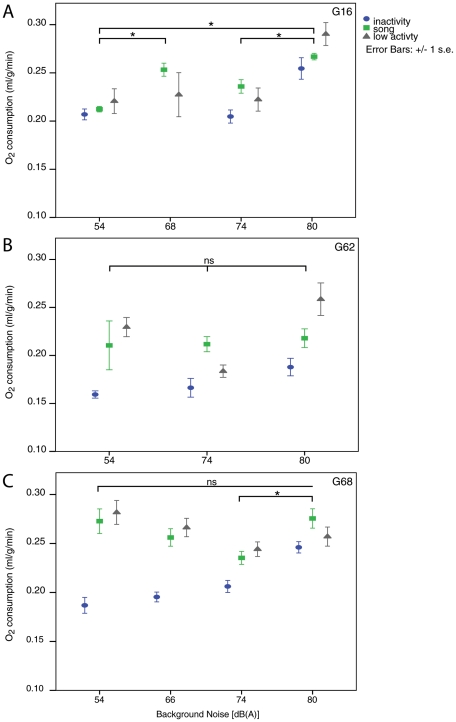
Rates of oxygen consumption during three categories of behaviour: song (green squares), low-level activity (grey triangles) and inactivity (blue circles) at different background noise conditions for three individuals.A) Rates of oxygen consumption were significantly higher during the quietest and loudest songs in only one bird, G16. However, the increase in oxygen consumption during periods of inactivity and low-level activity at the same background noise conditions were just as great, suggesting that the increase may not be due simply to the increase in song amplitude. B and C) Rates of oxygen consumption at low, intermediate and high background noise levels and song amplitudes were not significantly different in birds G62 or G68. All three birds showed an increase in oxygen consumption during periods of inactivity as background noise increased. Asterisks denote significance at p<0.01 levels for mean differences between means for rates of oxygen consumption during song at different amplitudes.